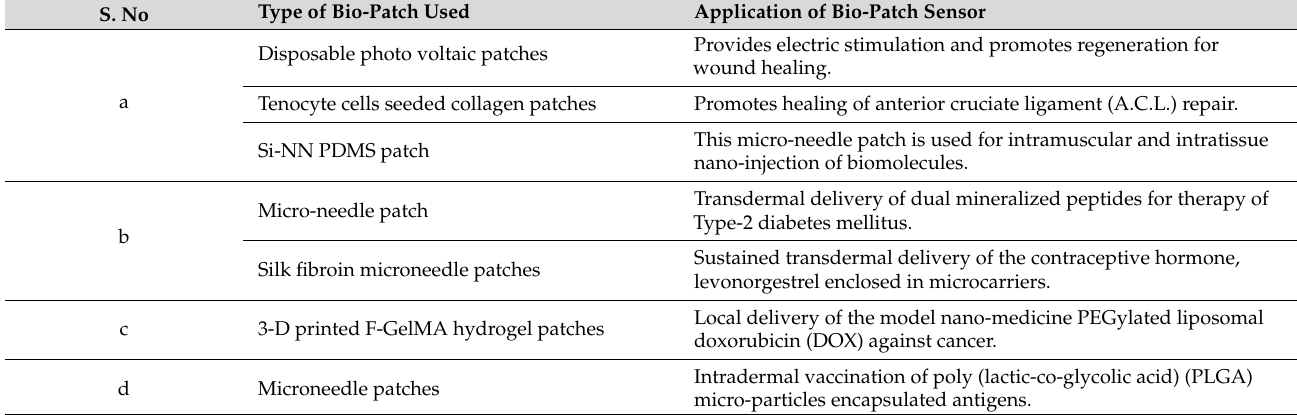
applications (Table 3): (a) to record ECG (electrocardiogram) and EMG (electromyogram) signals; further, the cardiac health sensor was designed to monitor bio-impedance in addi- tion to ECG; (b) human stress monitoring patch made of perforated polyamide membrane integrated with sensors for skin temperature, skin conductance, and a flexible pulse wave sensor to detect the pulse wave via multimodal biological signals; (c) flexible nanosensors can also be used to detect pathogenic organisms such as human immunodeficiency virus (HIV) and Escherichia coli ( E. coli ); (d) apart from its use as flexible and wearable nanosen- sors, flexible bio-patches have been identified as promising candidates for drug and vaccine administration and wound healing. Disposable photovoltaic patches were designed to deliver electric stimulation (ES), increase regenerative activity, and aid in wound healing. Thus, flexible bio-patches offer a plethora of applications in nanosensors and medicine. Table 3. The list of the applications of flexible bio patches other than an anchor/substrate to the flexible nanosensors. S. No Type of Bio-Patch Used Application of Bio-Patch Sensor Disposable photo voltaic patches Provides electric stimulation and promotes regeneration for wound healing. a Tenocyte cells seeded collagen patches Promotes healing of anterior cruciate ligament (A.C.L.) repair. Si-NN PDMS patch Micro-needle patch b Silk fibroin microneedle patches c 3-D printed F-GelMA hydrogel patches